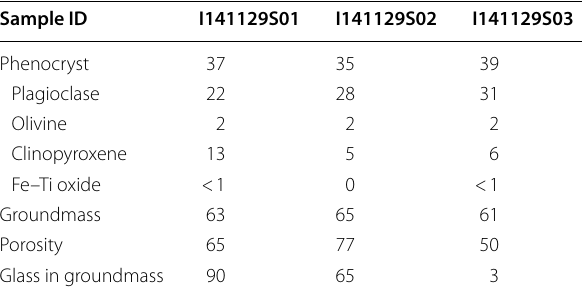
Table 2 Mode composition of scoria from the November 26–27, 2014, eruption (vol%). Porosity of the scoria and volume fraction of glass in groundmass are also shown (vol%)